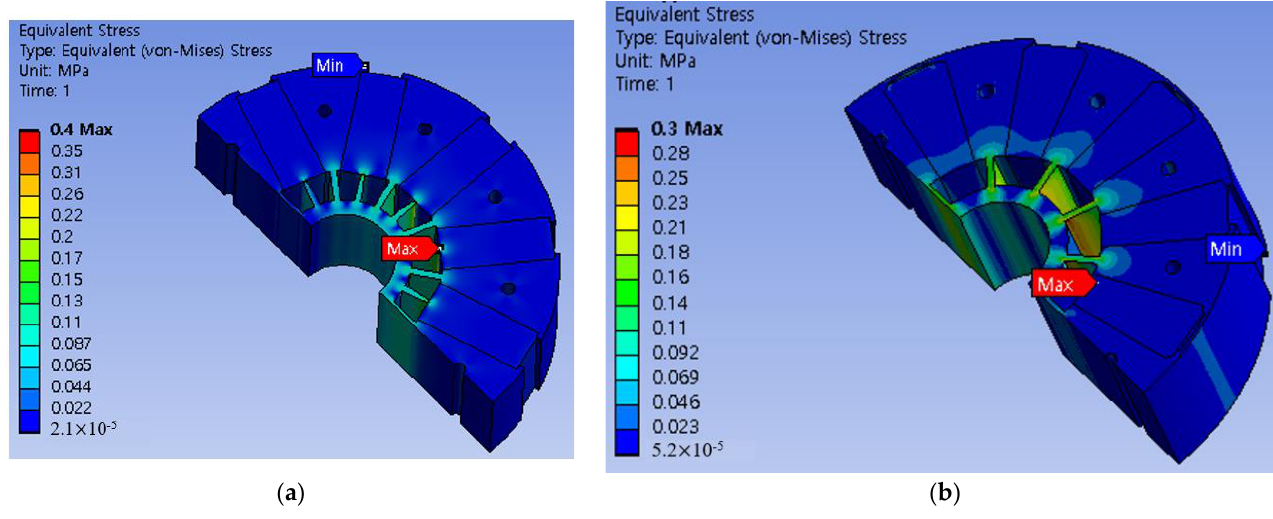
Figure 17. Comparison of maximum equivalent stress values during load operation ( a ) conventional model, ( b ) proposed model.